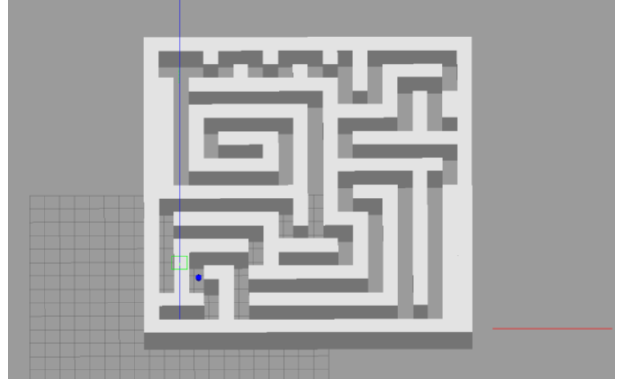
Figure 24. The robot navigates a complex 3D maze.